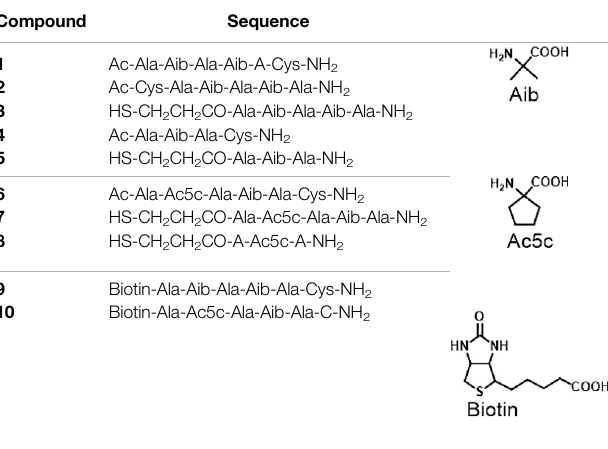
TABLE 1 | Synthesized peptides. The gold anchor point is indicated in